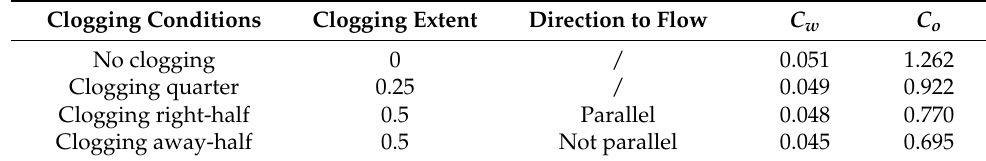
Table 4. Discharge coefficients of weir and orifice flow under different clogging extents of